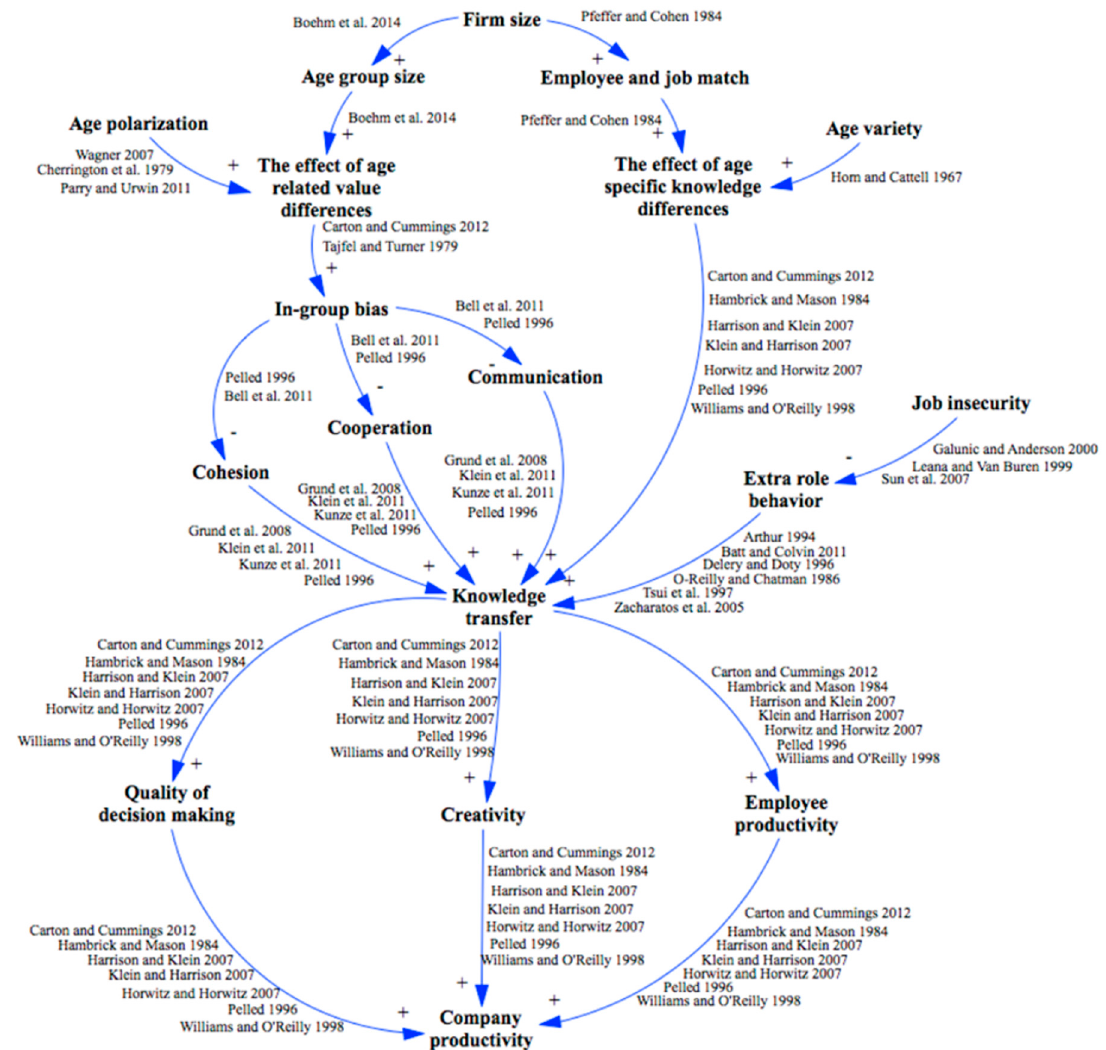
Figure 4. Authors drawing of the causal relationships from the literature of De Meulenaere et al.